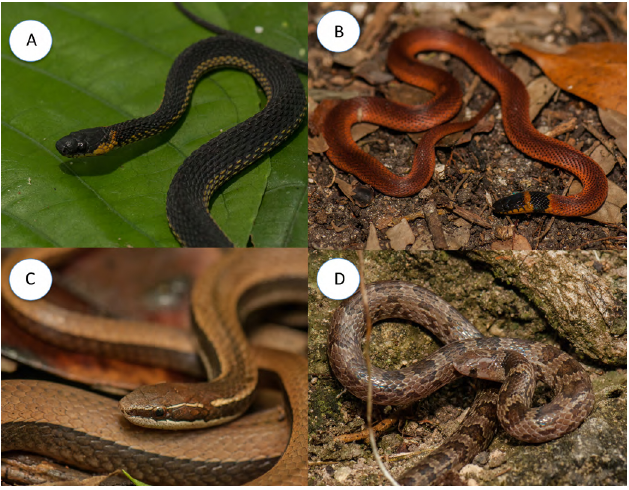
Figure 5. Amphibians encountered in the Calakmul Biosphere Reserve: ( A ) Bolitoglossa mexicana , Gastrophryne elegans , ( C ) Leptodactylus fragilis . Photos by TJC.